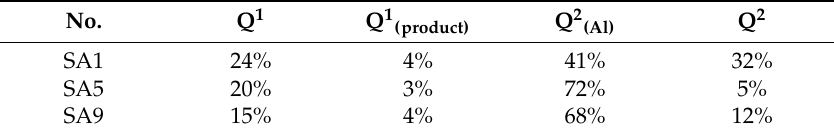
Table 4. Quantitative analysis of Q n in the paste of variable slag. 350